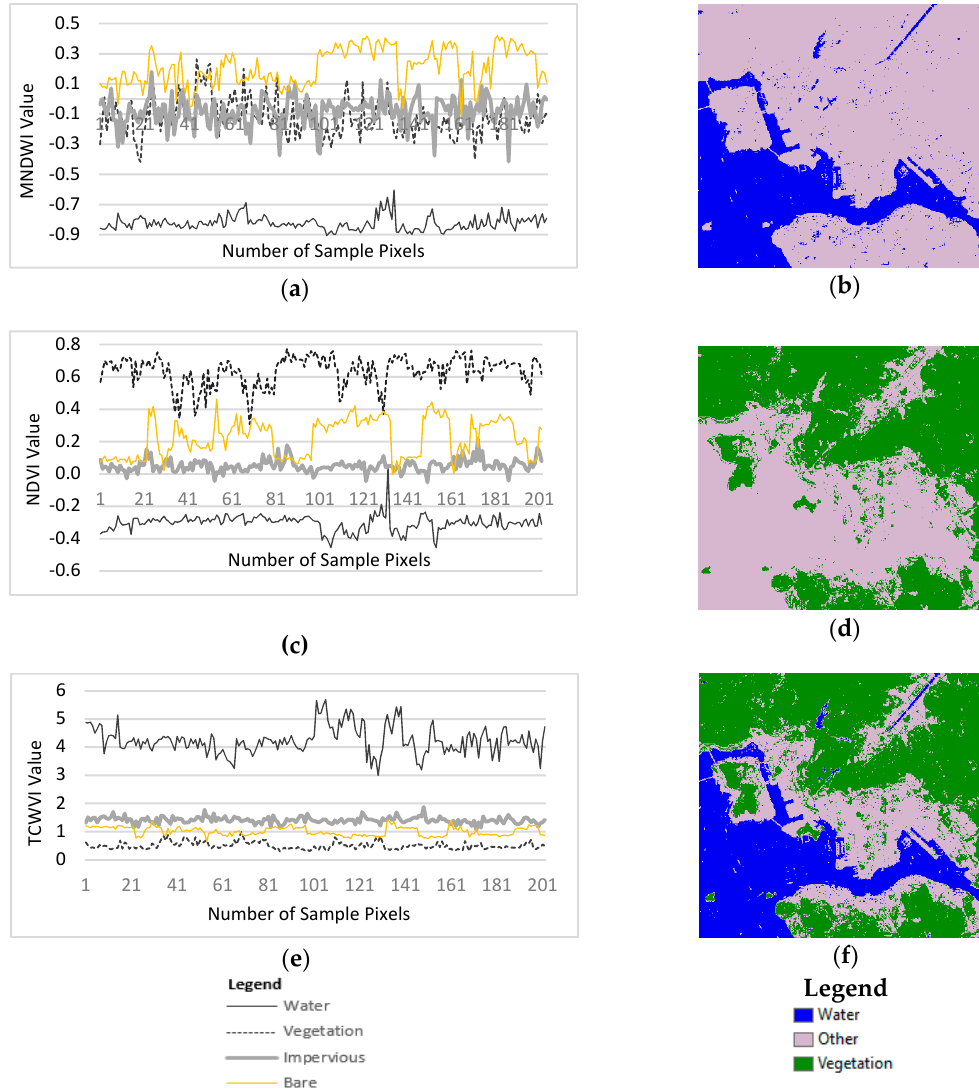
Figure 13. Water and vegetation detection in Hong Kong using ( a )-( b ) MNDWI, ( c )-( d ) NDVI, and ( e )-( f ) TCWVI.